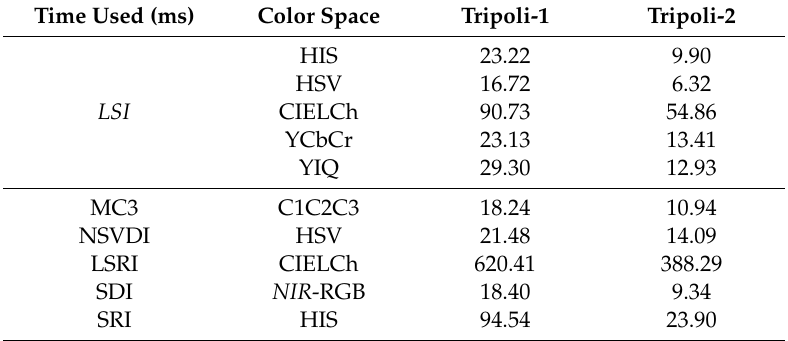
Table 3. Time consumption of various shadow detection algorithms for test images Tripoli-1 and Tripoli-2. Time Used (ms) Color